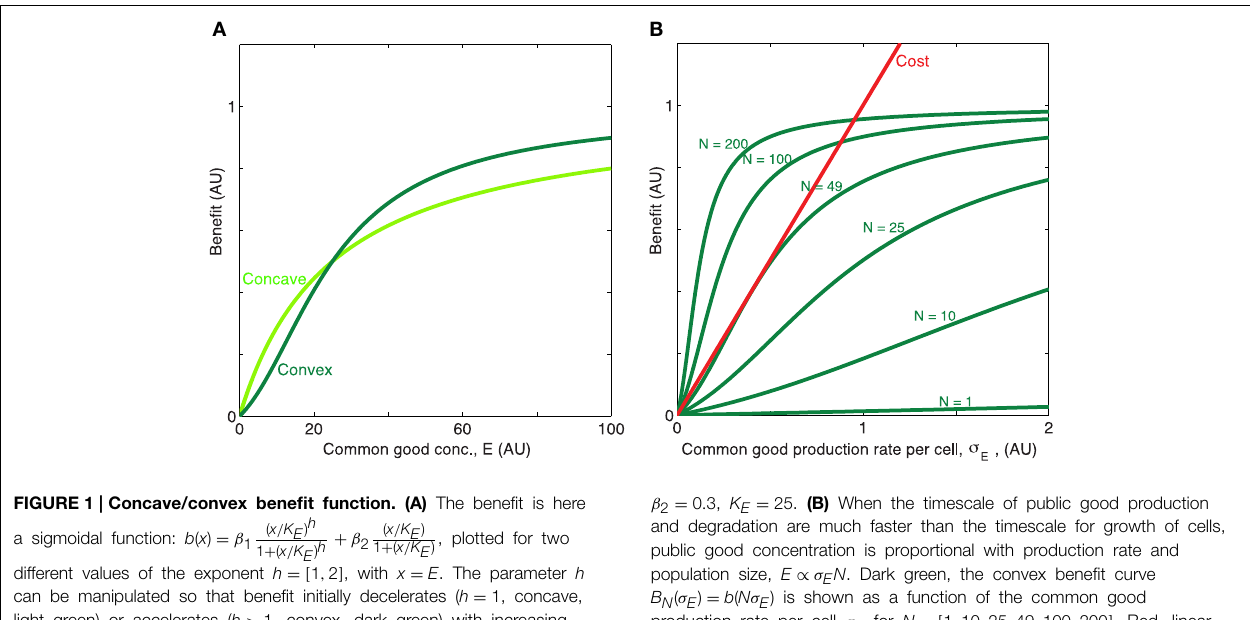
FIGURE 1 | Concave/convex benefit function. (A) The benefit is here β 2 = 0 . 3 , K E = 25 . (B) When the timescale of public good production h and degradation are much faster than the timescale for growth of cells, + β 2 ( x / KE ) a sigmoidal function: b ( x ) = β 1 ( x / KE ) 1 + ( x / KE ) , plotted for two public good concentration is proportional with production rate and 1 + ( x / KE ) h different values of the exponent h = [ 1 , 2 ] , with x = E . The parameter h population size, E ∝ σ E N . Dark green, the convex benefit curve can be manipulated so that benefit initially decelerates ( h = 1 , concave, B N ( σ E ) = b ( N σ E ) is shown as a function of the common good light green) or accelerates ( h > 1 , convex, dark green) with increasing production rate per cell σ E for N = [ 1 , 10 , 25 , 49 , 100 , 200 ] . Red, linear concentration of public good. The remaining parameters are β 1 = 0 . 7 , cost curve c ( σ E ) = κσ E , κ = 1